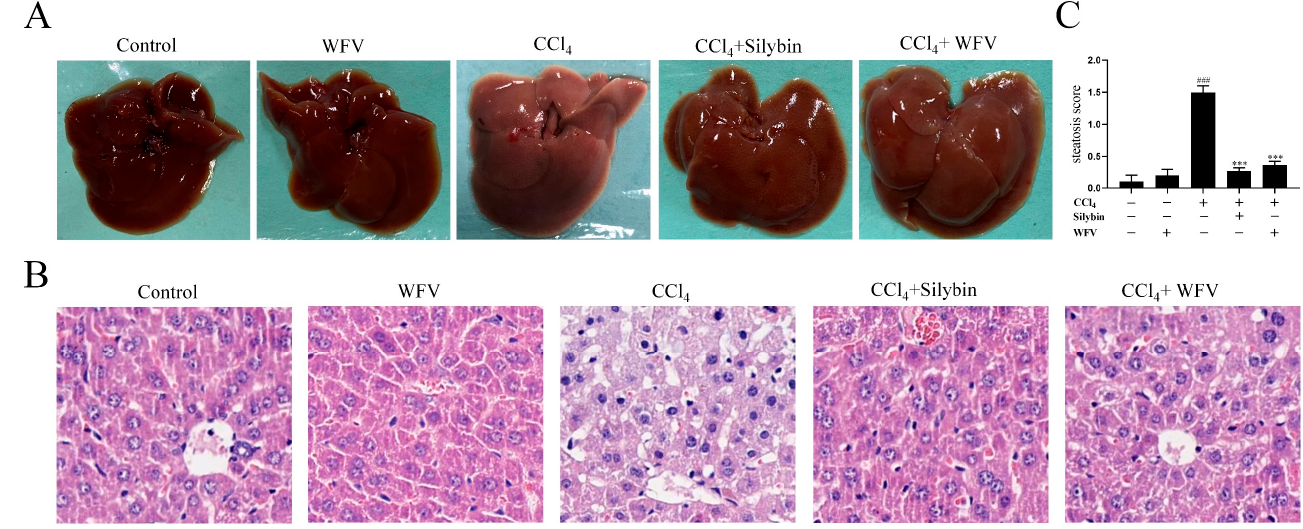
Figure 2. Effect of WFV on the damaged liver in mice. ( A ) Anatomical examination of liver in mice. ( B ) Hepatic tissues were dyed with H&E (200× magnification). ( C ) Steatosis score of liver in mice. ( B ) Hepatic tissues were dyed with H&E (200 × magnification). ( C ) Steatosis score of liver in mice. ### p < 0.001 vs. control group. *** p < 0.001 vs. model group. ### p < 0.001 vs. control group. *** p < 0.001 vs. model